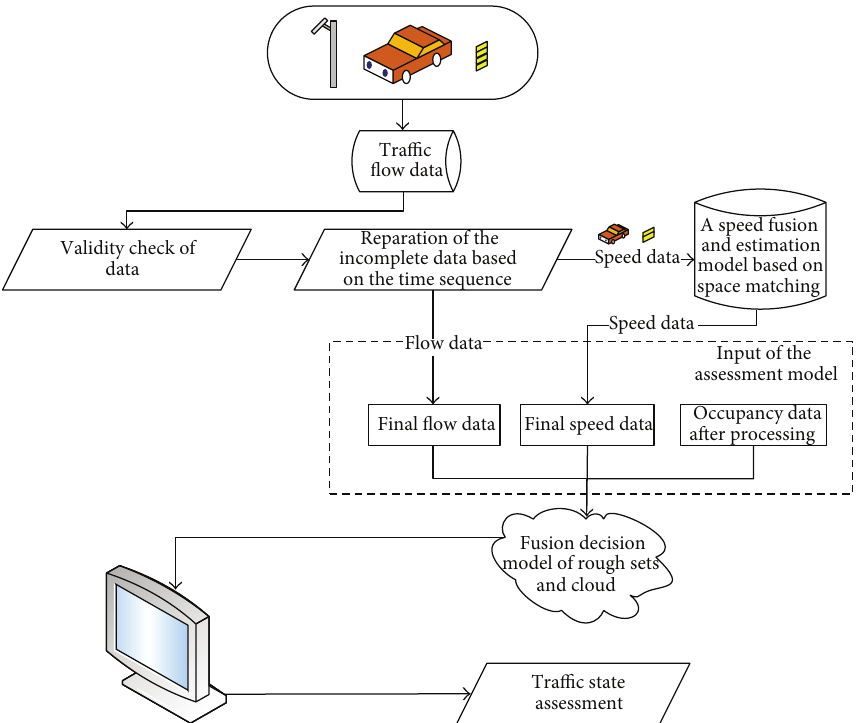
Figure 2: Overall flow chart of the proposed assessment method.